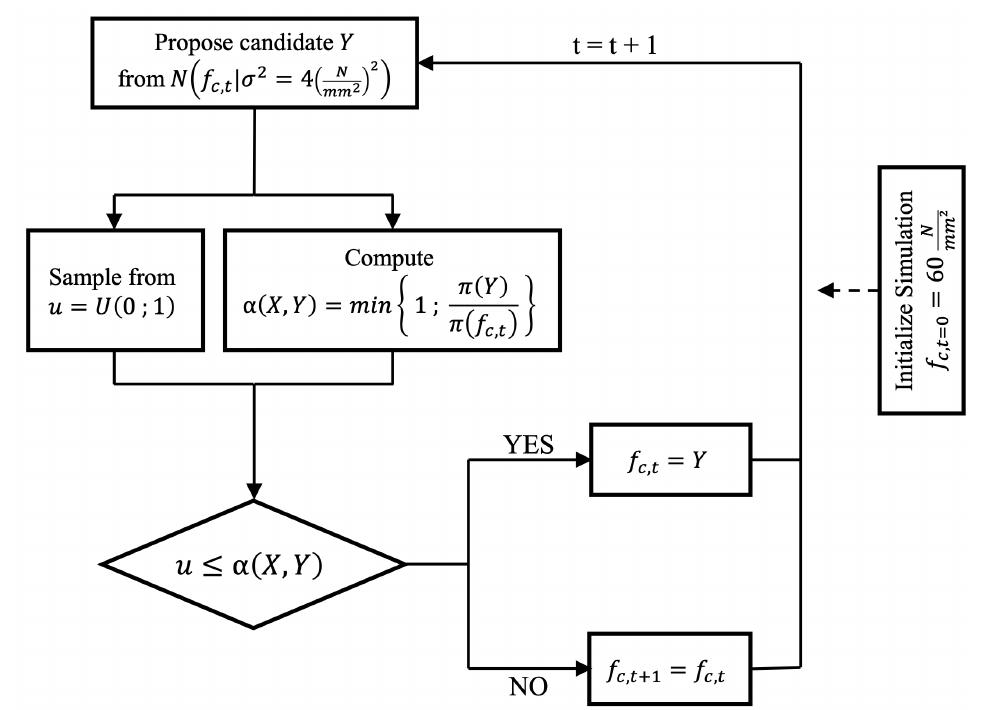
Figure 3. Flowchart of the applied algorithm for sampling from the posterior distribution π ( ·